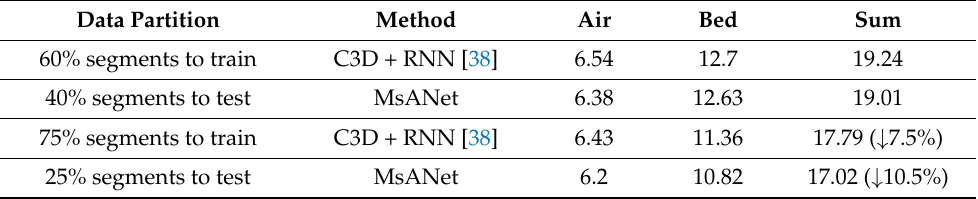
Table 8. Experimental results with different divisions of 97 segments